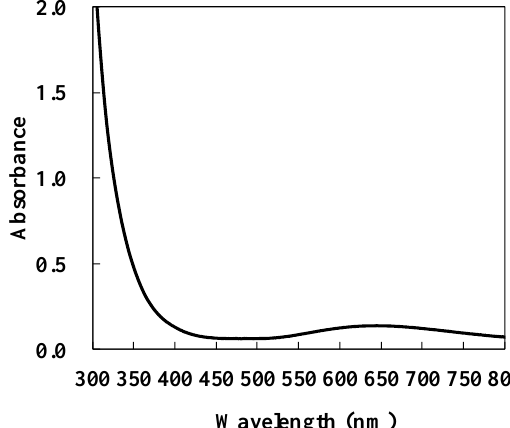
Figure 2. Absorption spectrum of GACu complex thin film.